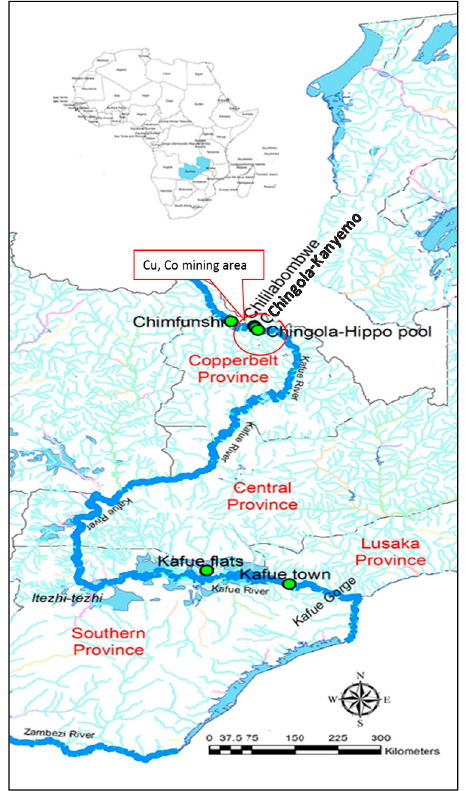
Figure 1. Map of Zambia showing the location of the Copperbelt mining area and sampling sites along the Kafue River.